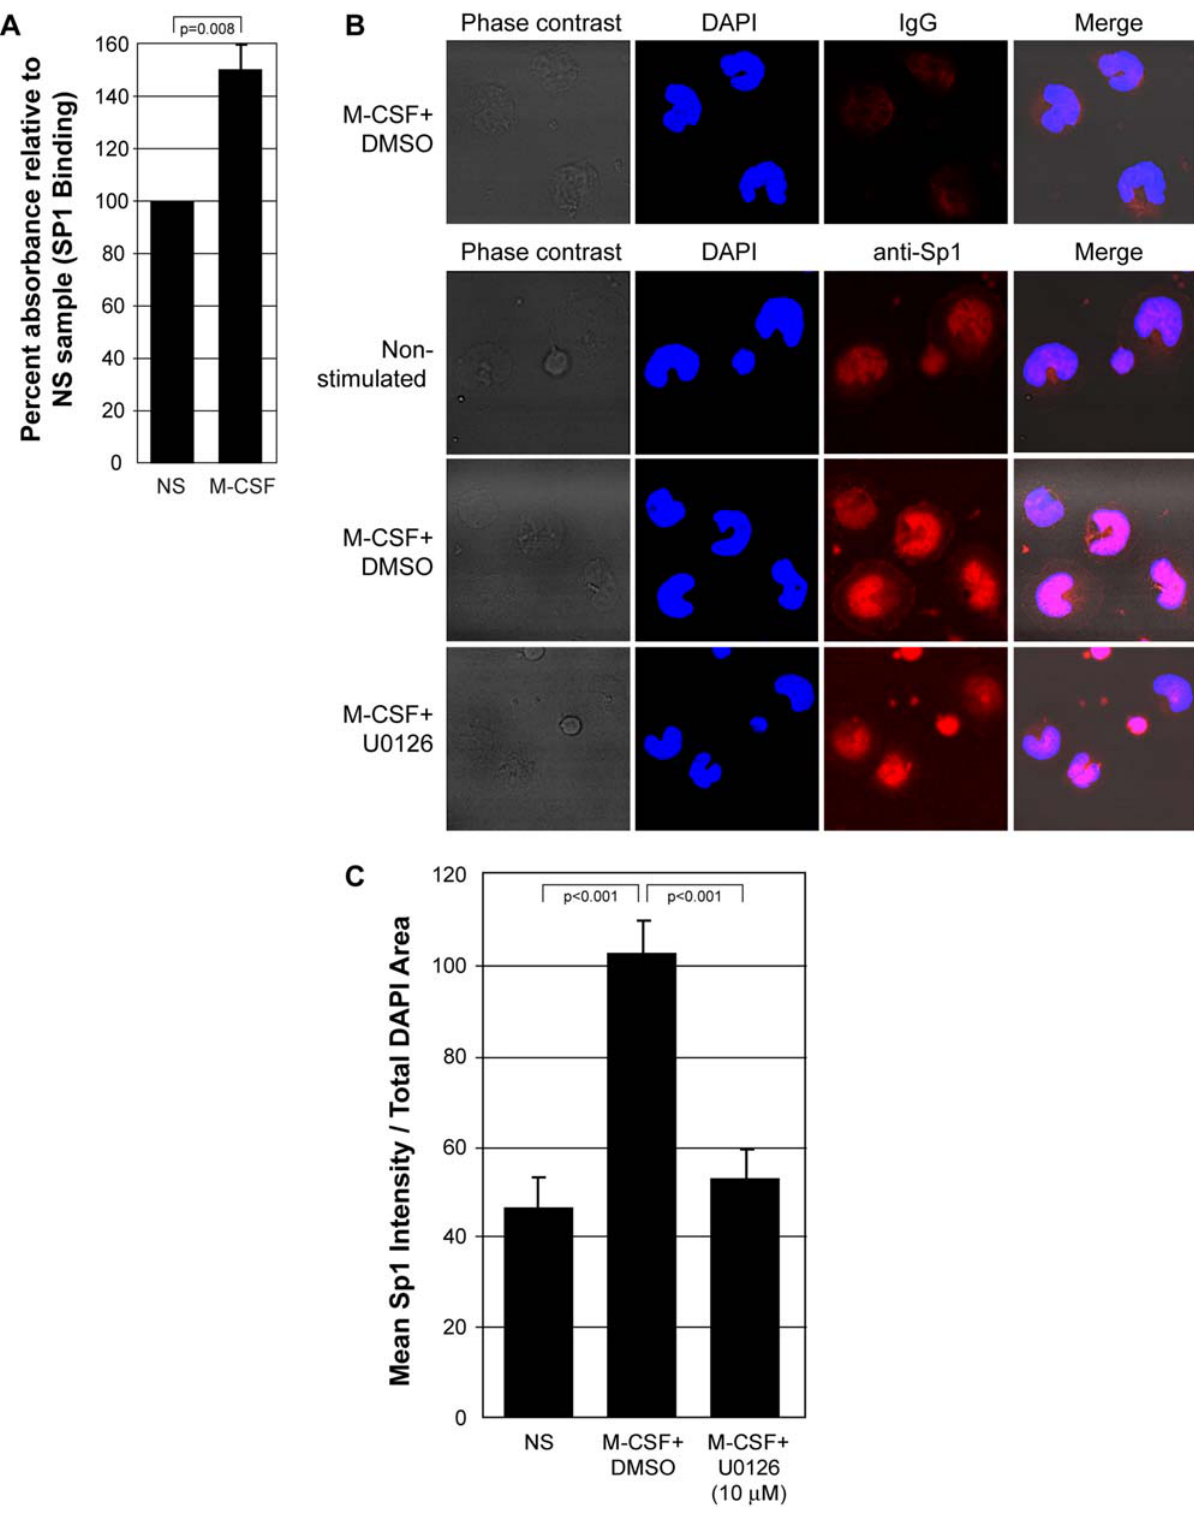
Figure 3. M-CSF induces Sp1 nuclear localization in an ERK-dependent manner. A) Human monocytes were left non-stimulated (NS) or stimulated with rhM-CSF (100 ng/ml) (M-CSF) for 30 minutes. Nuclear lysates were isolated and normalized for total protein. Sp1 that translocated into the nucleus in response to M-CSF was analyzed using a biotinylated Sp1 DNA sequence bound to a streptavidin-coated plate, a polyclonal rabbit anti-Sp1 primary antibody, a HRP-conjugated goat anti-rabbit IgG secondary antibody, and TMB substrate. The absorbance was read at 450 nm to reflect Sp1 within the nucleus. These data represent the mean 6 SEM from four independent blood donors. B) Human monocytes were starved for 6 hours, inhibited for 30 minutes with U0126 (10 m M) or DMSO (vehicle control) and left non-stimulated (Non-stimulated) or treated with rhM-CSF for 6 hours (M-CSF + DMSO) and (M-CSF + U0126) . The cells were fixed, permeablized, and stained with a normal IgG control antibody (top row) or a primary